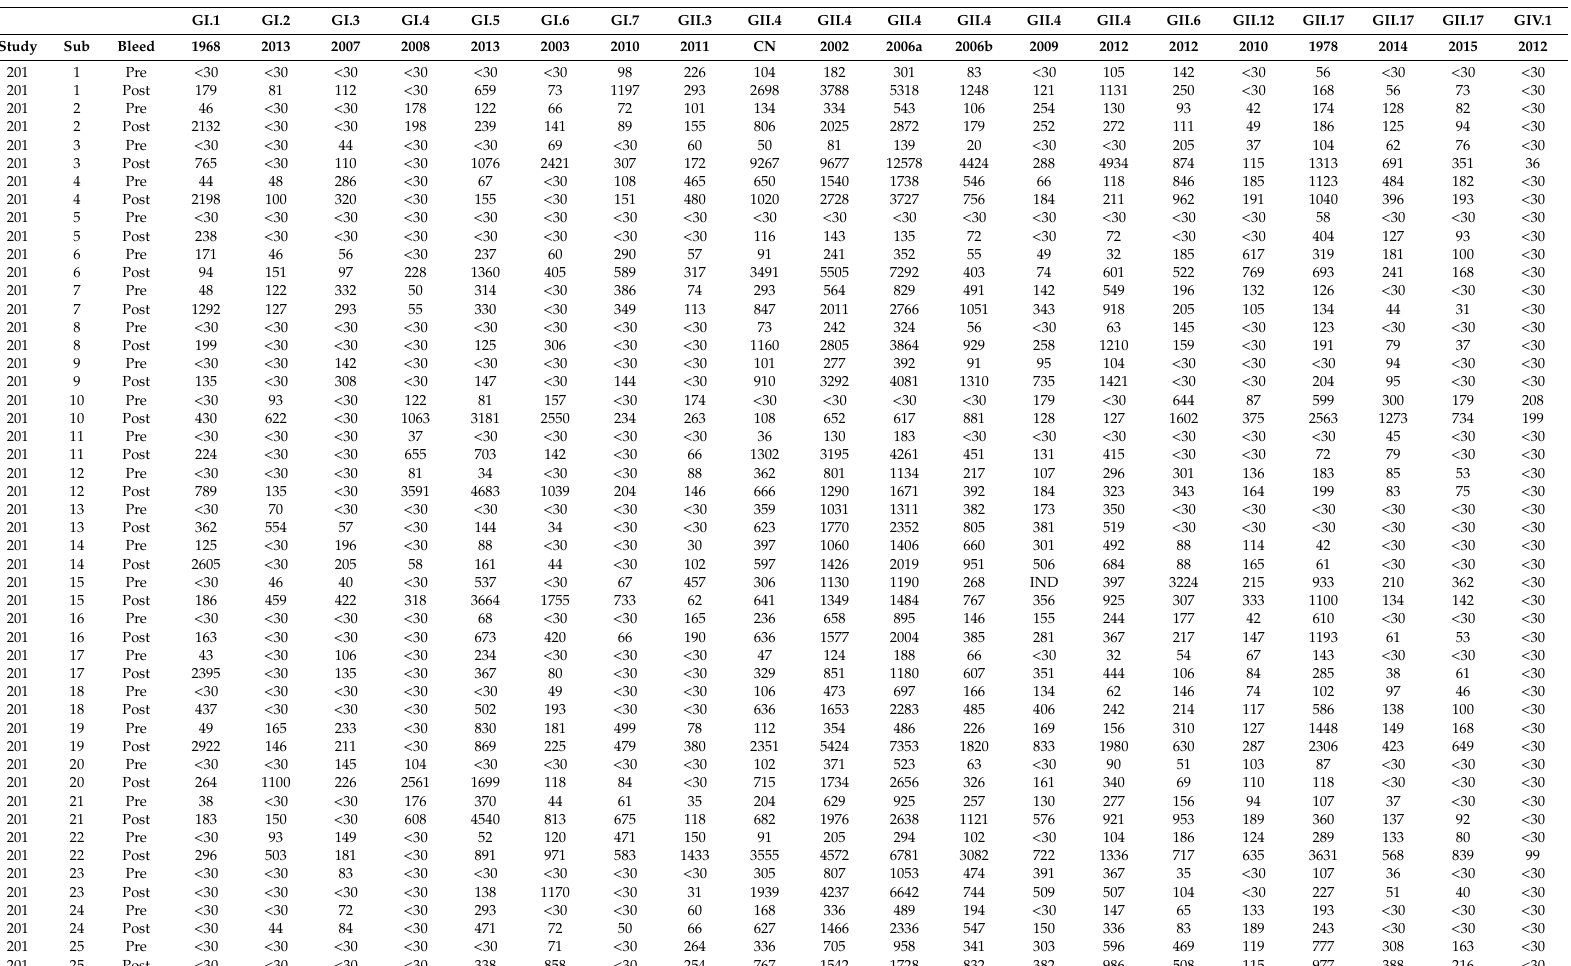
Table A2. Blockade titers measured in sera from subjects enrolled in the NOR-201 clinical